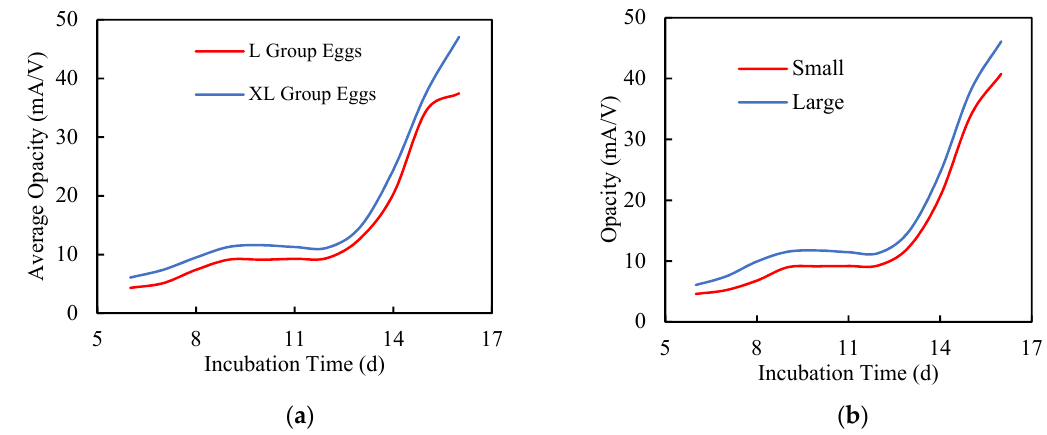
Figure 3. Patterns of opacity curves for various groups of eggs during incubation (days 6–16). Longer major axis eggs had higher opacity due to a longer optical path. ( a ) Growth pattern of embryos from small and large eggs. ( b ) Growth pattern of small and large major axis eggs.